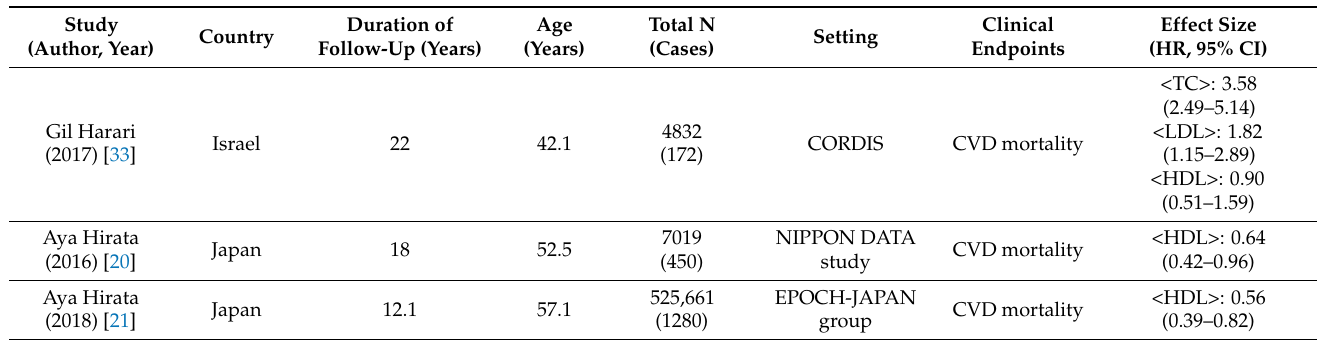
Table 1. Cont. Figure 1. Flowchart of the study selection .